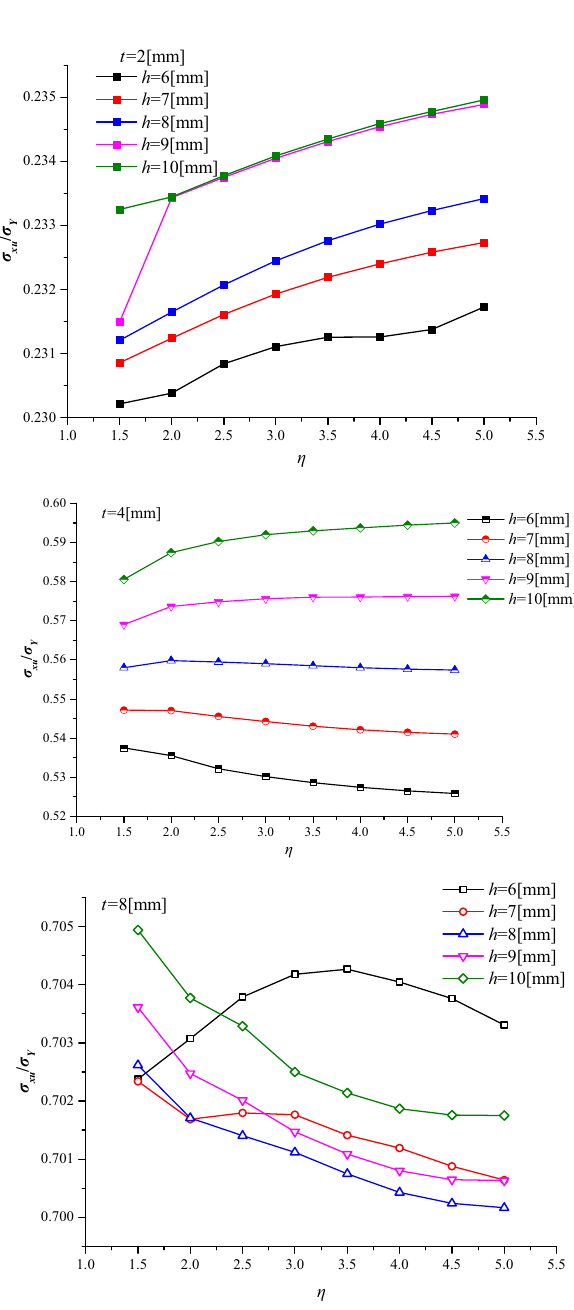
Figure 9: In fl uence of cutout shape on ultimate